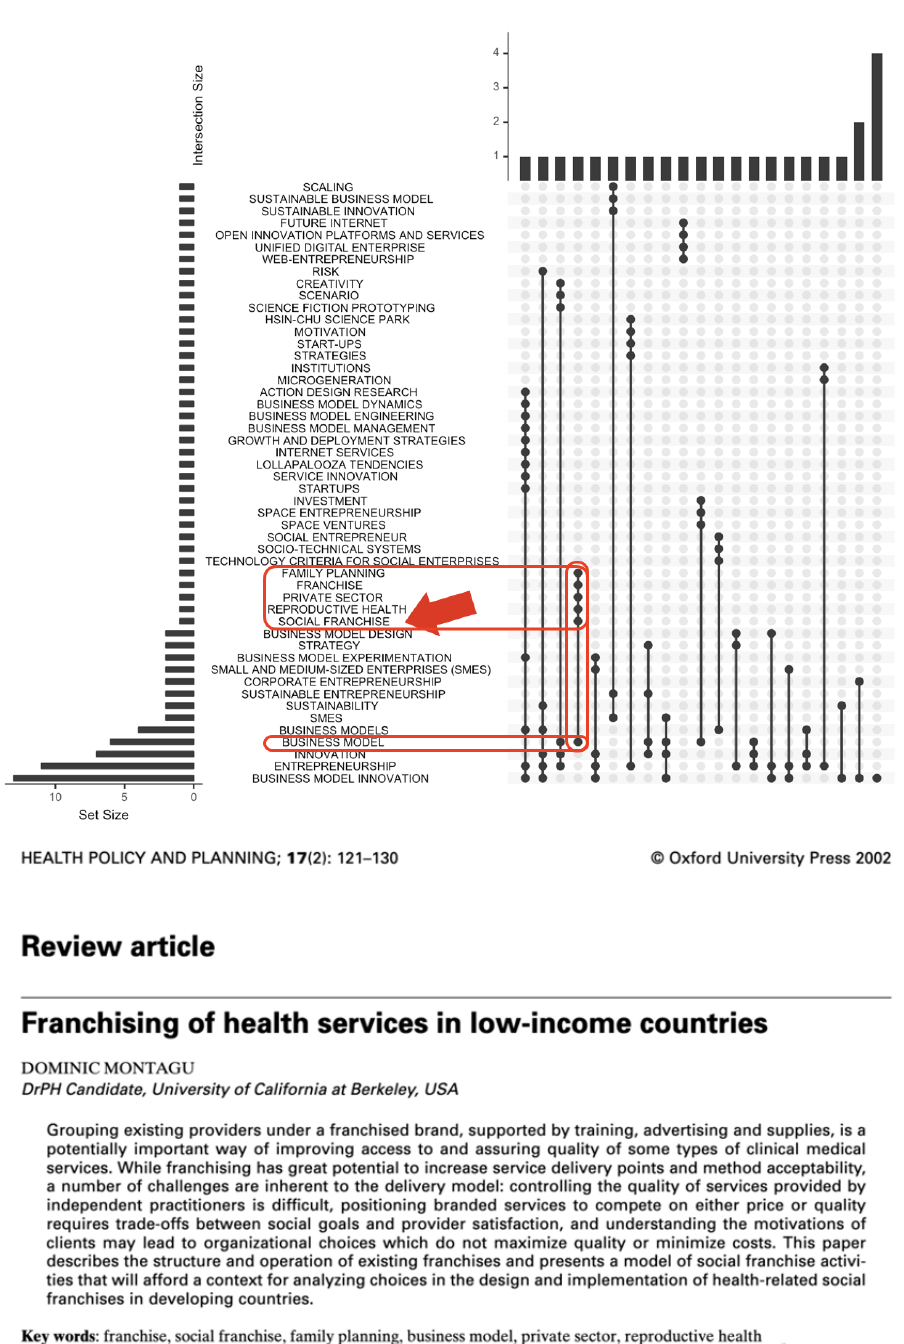
Fig. 6. Visualizing intersecting sets (sets of keywords appearing together in papers) (above); The selected papers and the keywords found in the intersecting sets (below)